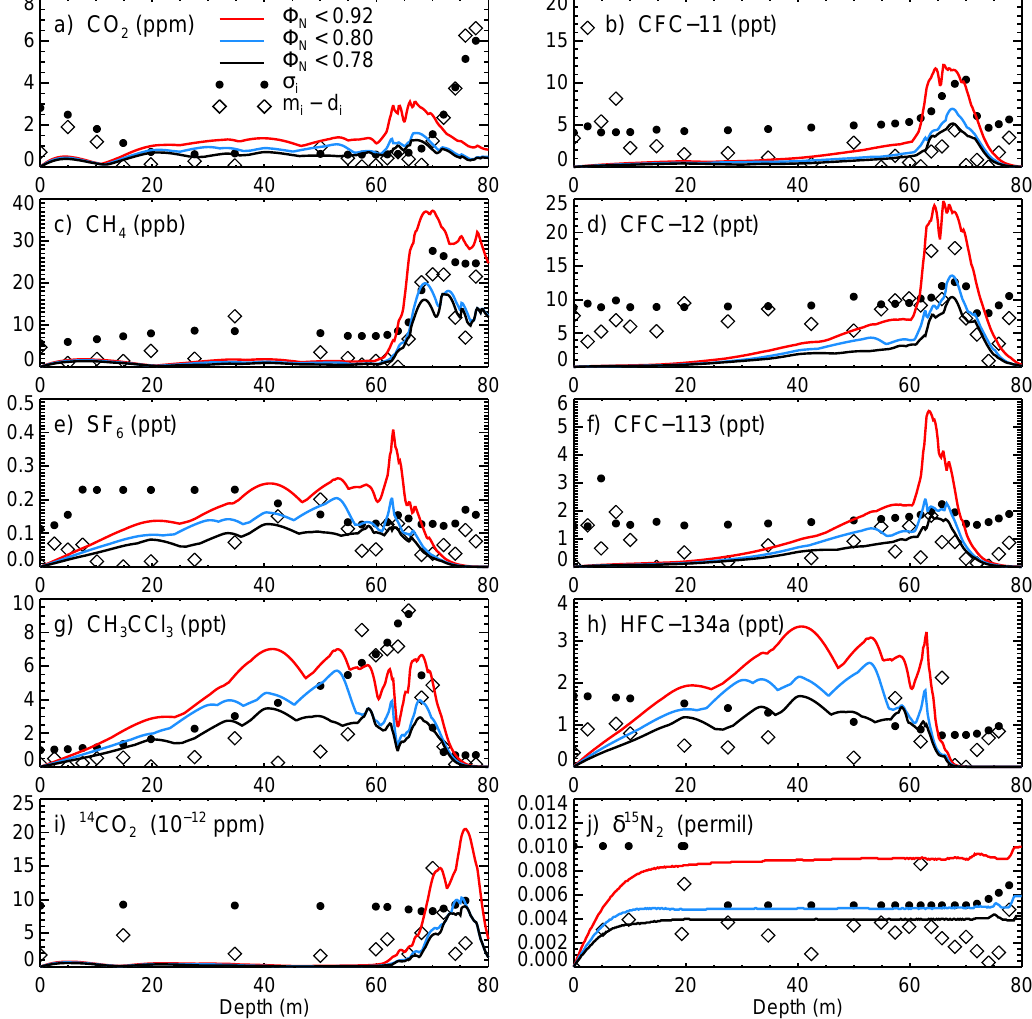
Fig. 7. For each tracer, the solid lines show half the range of all accepted solutions with 8 N < 0 . 78 (black), 8 N < 0 . 8 (blue) and 8 N < 0 . 92 (red) for the case NEEM TenEddy. Filled circles show the observation uncertaintes (1 σ ), and open diamonds show the absolute value of the mismatch between our best solution and the